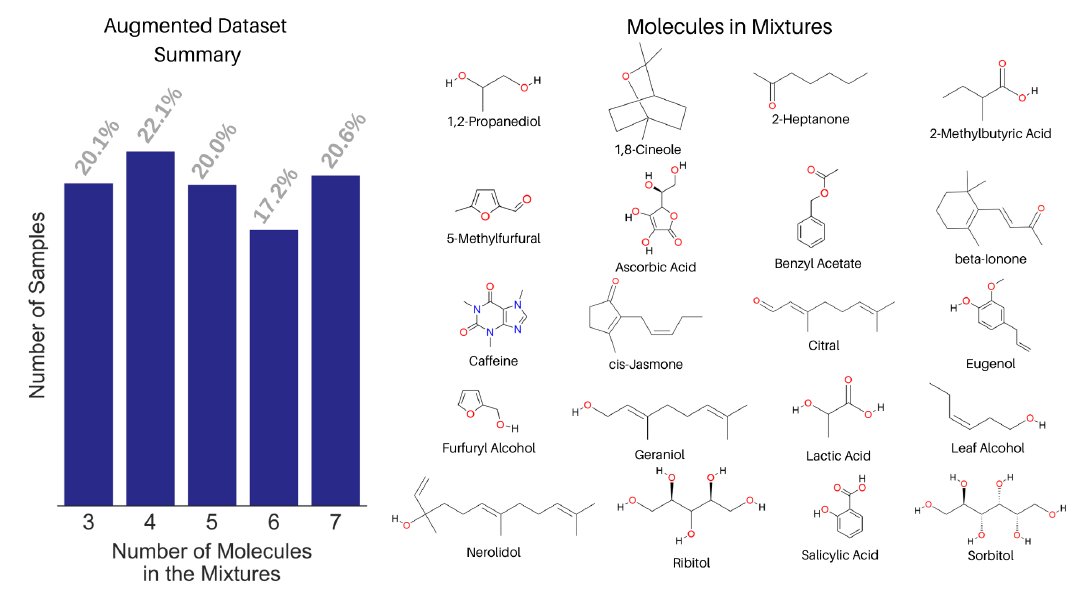
Figure 7. Summary of the augmented NMR spectral dataset with the fraction of samples against the number of constituent molecules in the mixtures (left) and the structure of the 20 molecules used in creating the augmented dataset